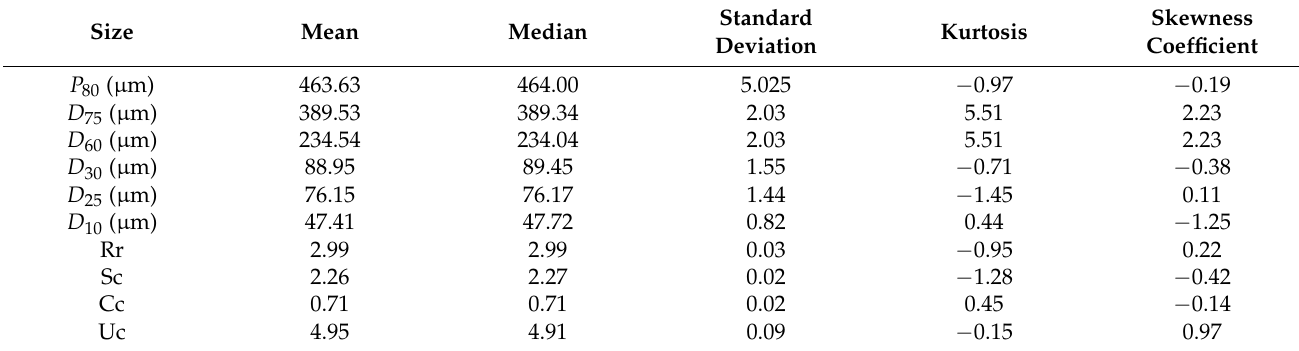
Table A12. Descriptive statistics for ore a under 8 min grinding for descriptive parameters of PSD.